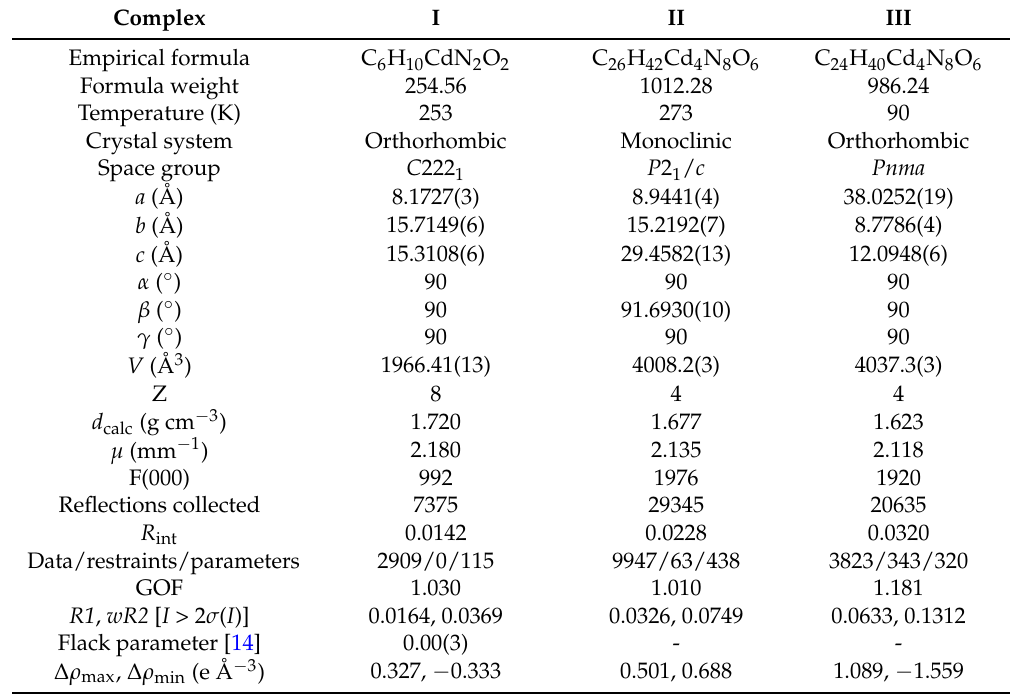
Table 1. Crystal Data for I , II and III .